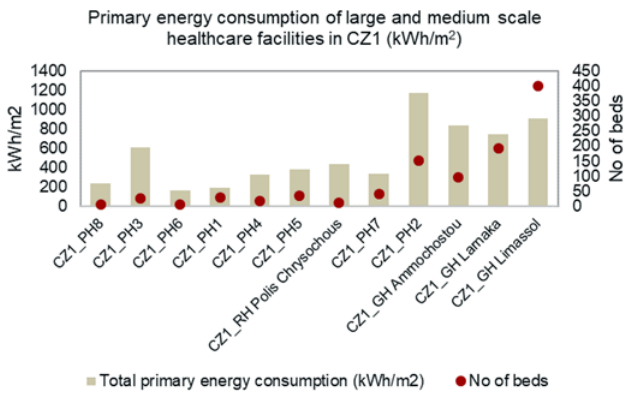
Fig. 6. Primary energy consumption of hospitals related to size and number of beds in CZ1.